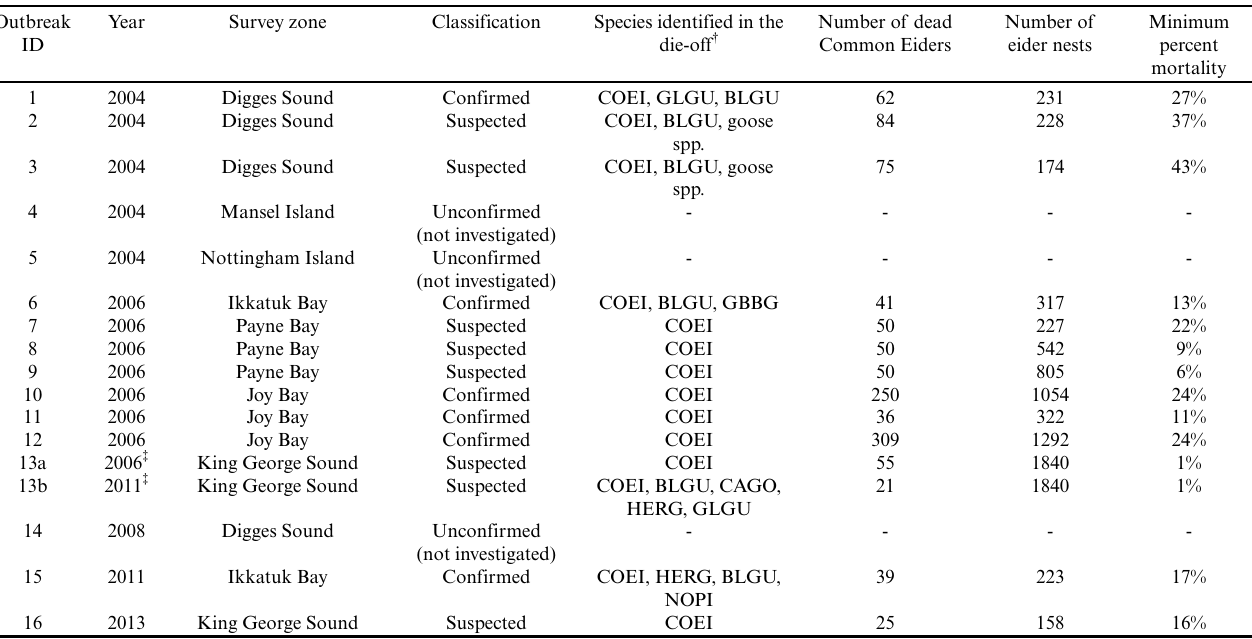
† Species codes: BLGU, Black Guillemot ( Cepphus grylle ); CAGO, Canada Goose ( Branta canadensis ); COEI, Common Eider; GBBG, Greater Black-backed Gull ( Larus marinus ); GLGU, Glaucous Gull ( Larus hyperboreus ); goose spp., unspecified goose; HERG, American Herring Gull ( Larus smithsonianus ); NOPI, Northern Pintail ( Anas acuta ). ‡ Recurrent outbreak at the same location.